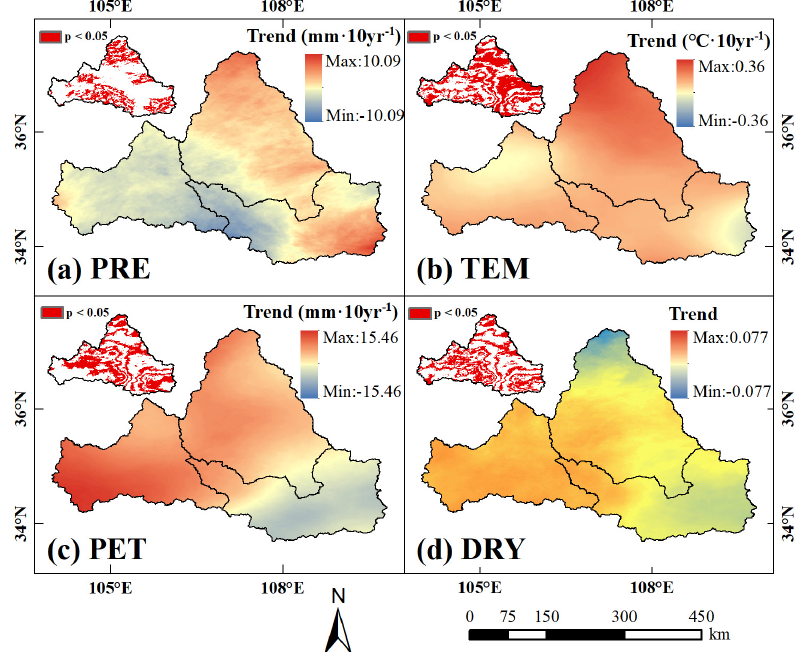
Figure4. Spatialdistributionoftrendsoffourmeteorologicalvariables, ( a )precipitation, ( b )temperature, Figure 4. Spatial distribution of trends of four meteorological variables, ( a ) precipitation, ( b ) ( c ) potential evapotranspiration, ( d ) dryness, during temperature, ( c ) potential evapotranspiration, ( d ) dryness, during 1961–2016.